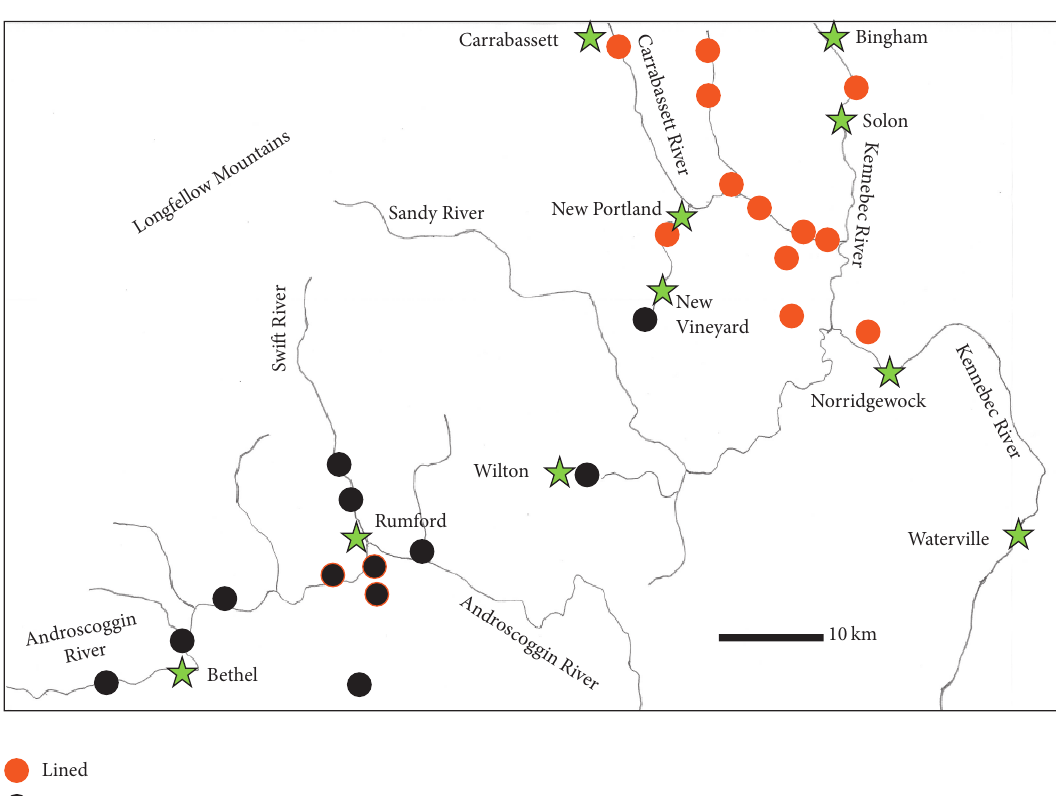
Figure 6: Distribution of Prosapia ignipectus populations with lined, black, and mixed dorsal color forms at the northeastern extremity of the species range in Maine. Some closely spaced localities sampled are represented by a single color symbol. In New Vineyard, a single partially lined specimen was observed among 114 specimens collected; the rest were